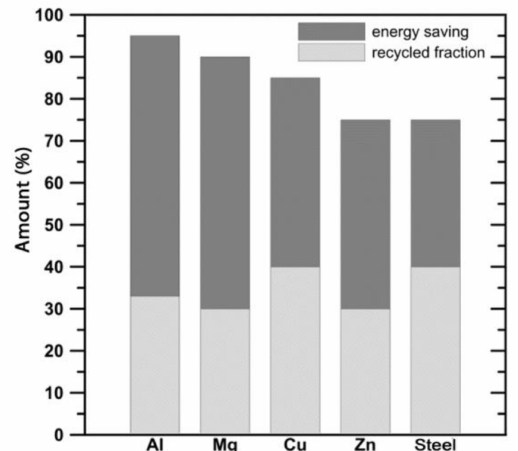
Figure 1. Energy saving from different metals with reference to the primary production route, and relative recycled fraction. Data refer to 2016 and are elaborated from